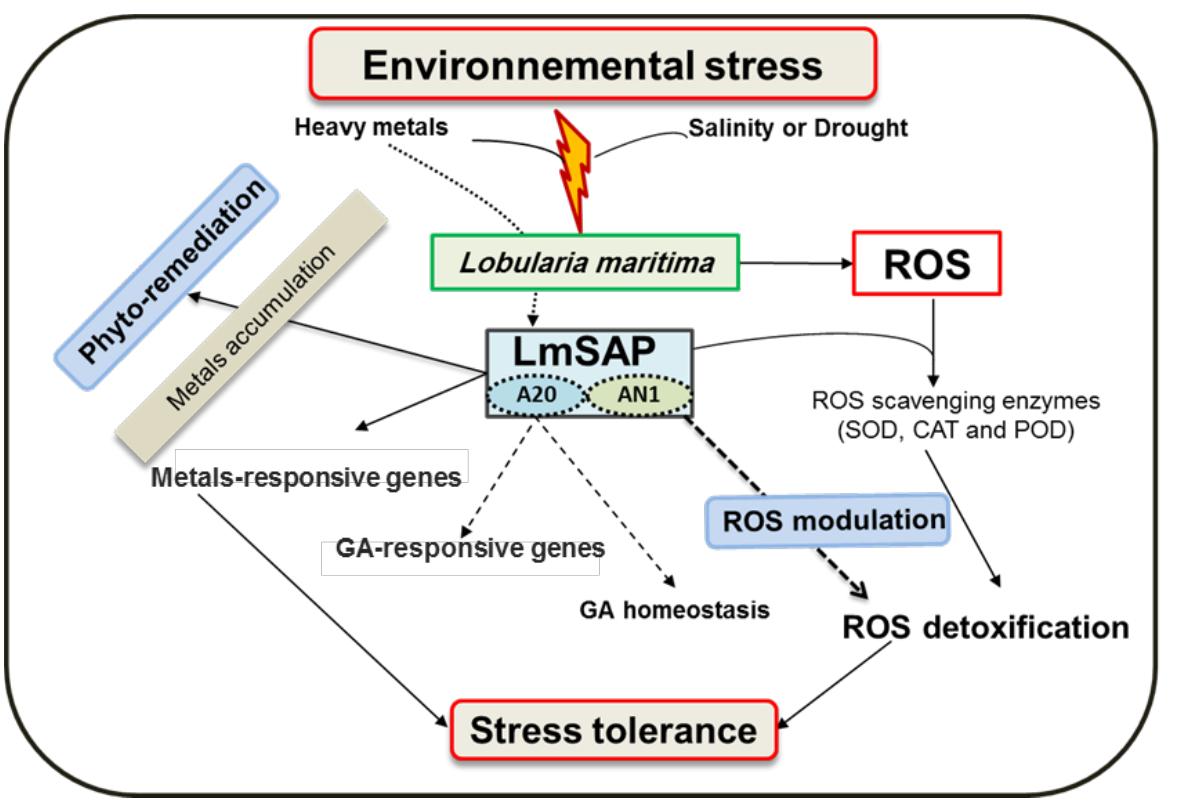
Figure 3. Hypothetical model for LmSAP -mediated abiotic stress tolerance via ROS modulation, GA homoeostasis, and heavy metals accumulation.